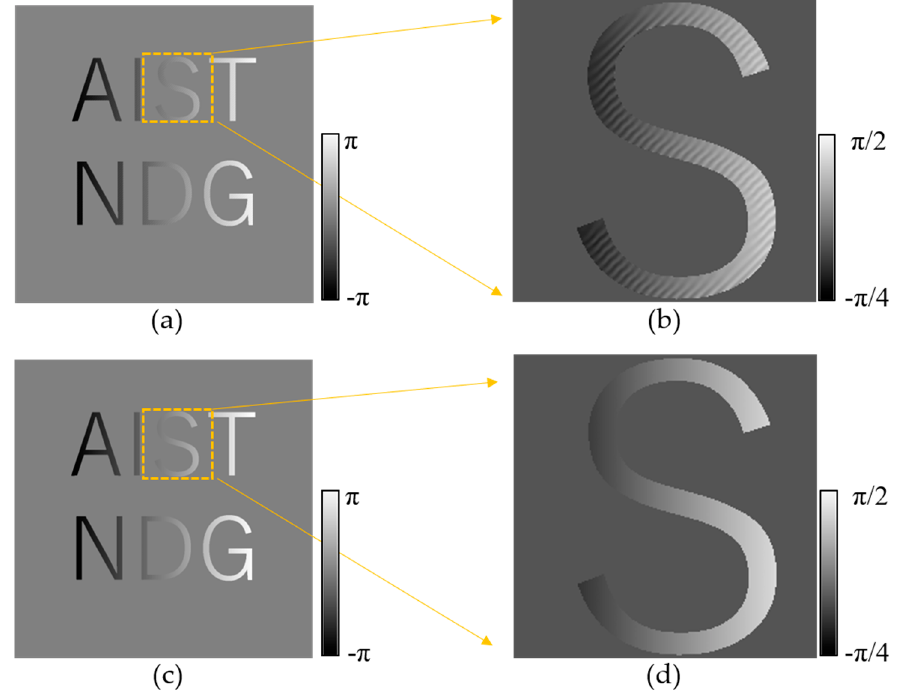
Figure 5. Simulation results of the amplitude images. ( a , c ) Amplitude images reconstructed by the conventional method and the proposed method, respectively; ( b , d) Magnified images of the areas indicated in ( a , c ), respectively. Appl. Sci. 2018 , 8 , x FOR PEER REVIEW